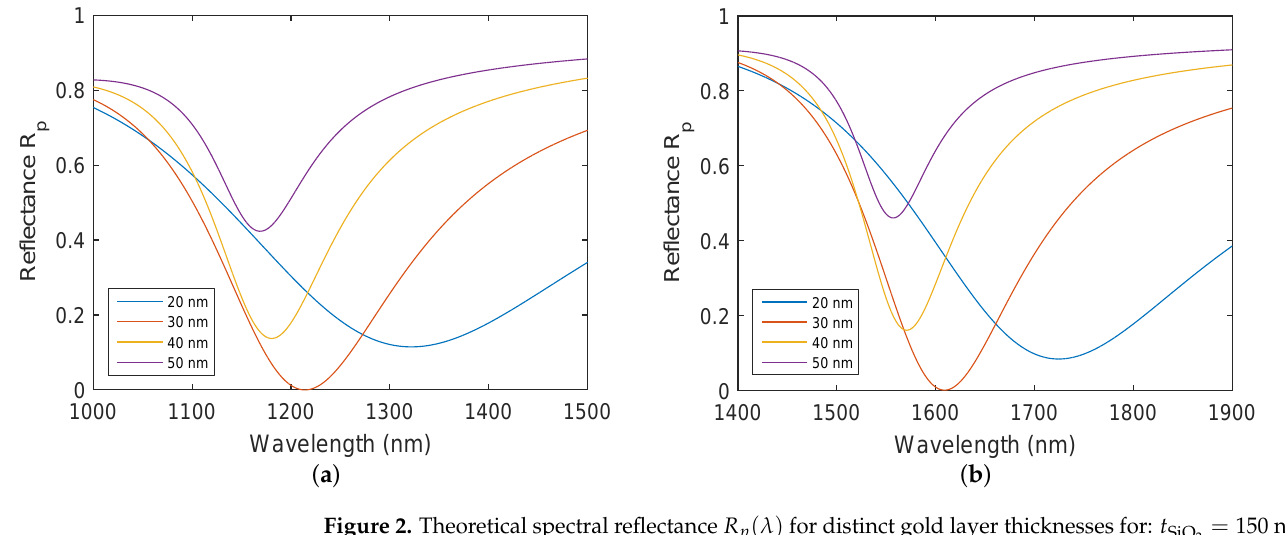
= 150 nm 2 = 2 nm. Cr